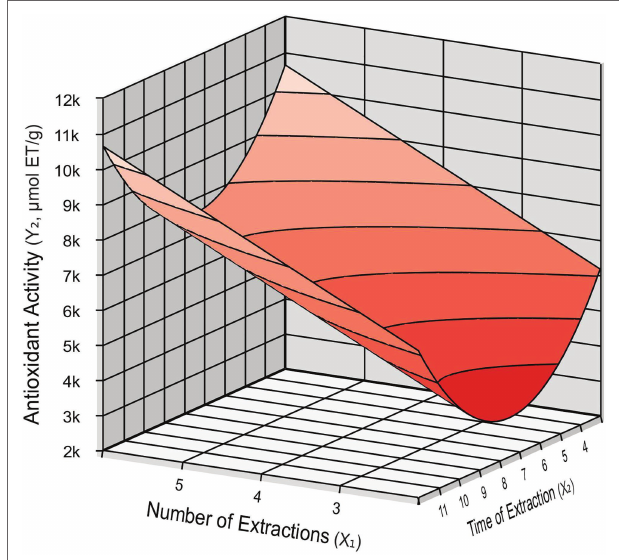
FIGURE 1 | Response surface for antioxidant activity as a function of the number of extractions ( X 1 ) and time of extraction ( X 2